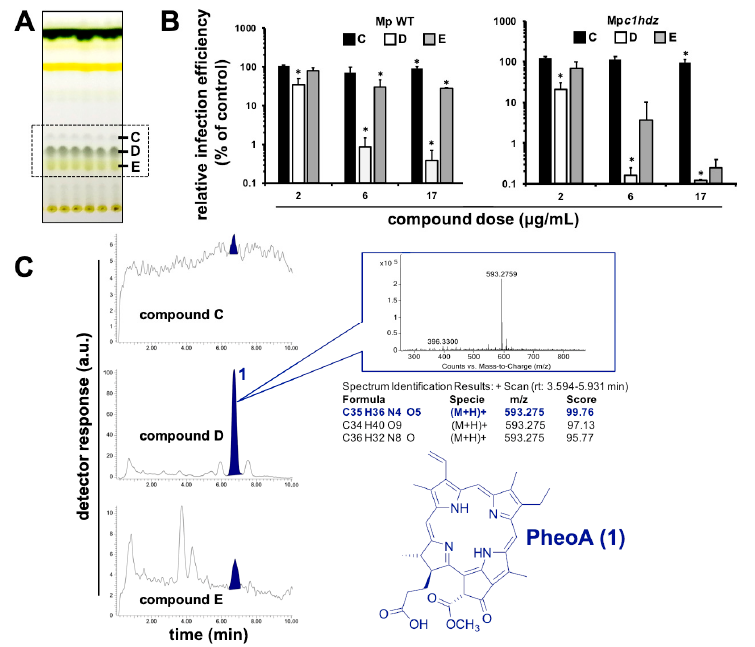
Figure 3. Identification of the main antiviral compound in Marchantia extracts. ( A ) Representative TLC of Marchantia WT and c1hdz extracts. Compounds C, D and E (box) were tested for their antiviral potential. ( B ) Vero E6 cells were inoculated (MOI = 0.01) in the presence of the indicated compounds and incubated for 24 h before fixation and processing for immunofluorescence microscopy. Data are shown as average ( ± SD) of three biological replicates. Statistical significance was estimated using one-way ANOVA and a Dunnet ´ s post hoc test (* p < 0.05). ( C ) Representative HPLC/MS analysis (shown for WT) of fractions C, D, and E, including exact mass determination of the antiviral candidate 1, and its inferred chemical